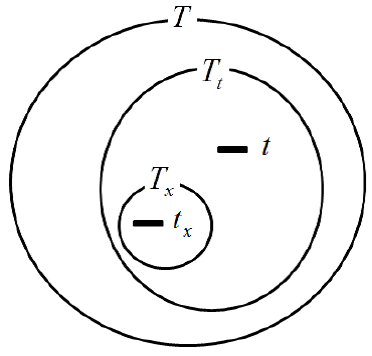
Figure 11. Relationships among T x , T t and T